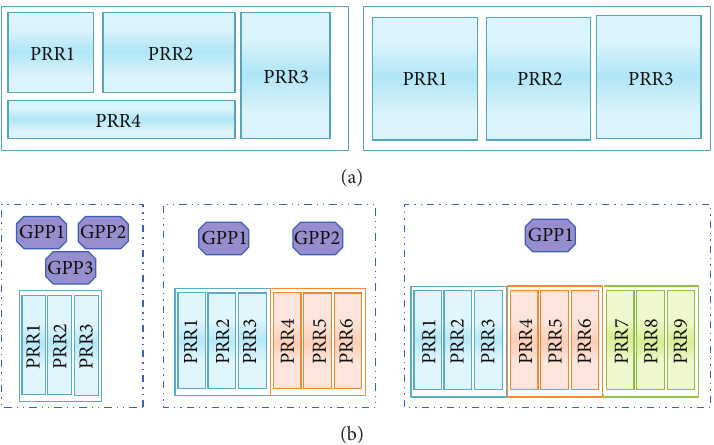
Figure 1: (a) PRR layout, (b) miscellaneous platforms/floorplans.